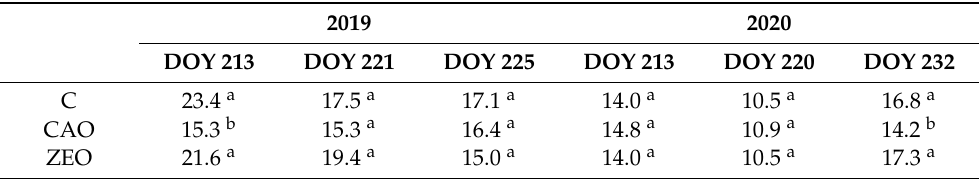
Table 5. The leaf assimilation rate (A n , µ mol m − 2 s − 1 ) during the 2019 and 2020 seasons. Measure- ments were taken on three well-exposed leaves per vine. Different letters within a column indicate significant differences as calculated by the Tukey statistical analysis test ( p ≤